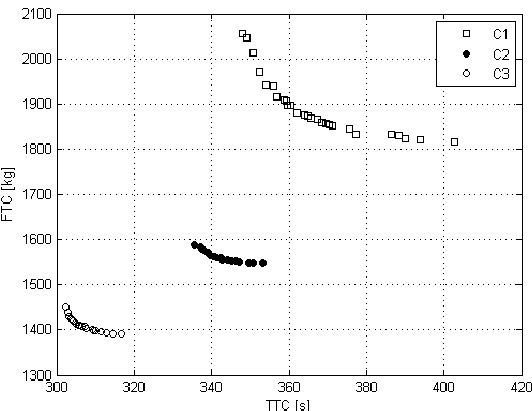
contours of: Specific Excess Power (m/s) ( a ); and Energy Efficiency (m/kg) ( b ).